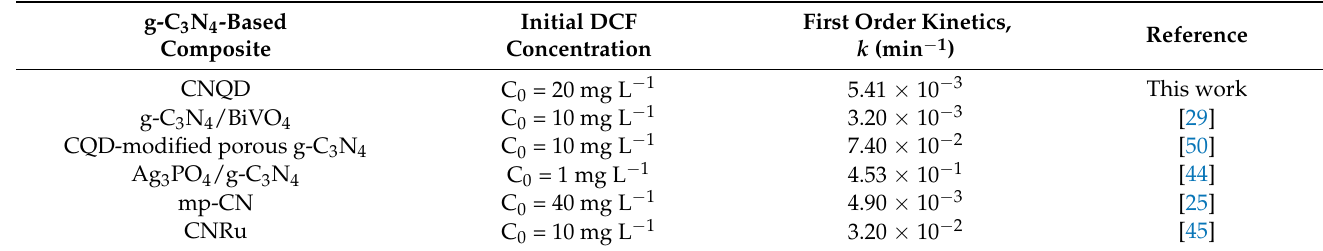
Table 3. Comparison of degradation performance of DCF with the cited studies.